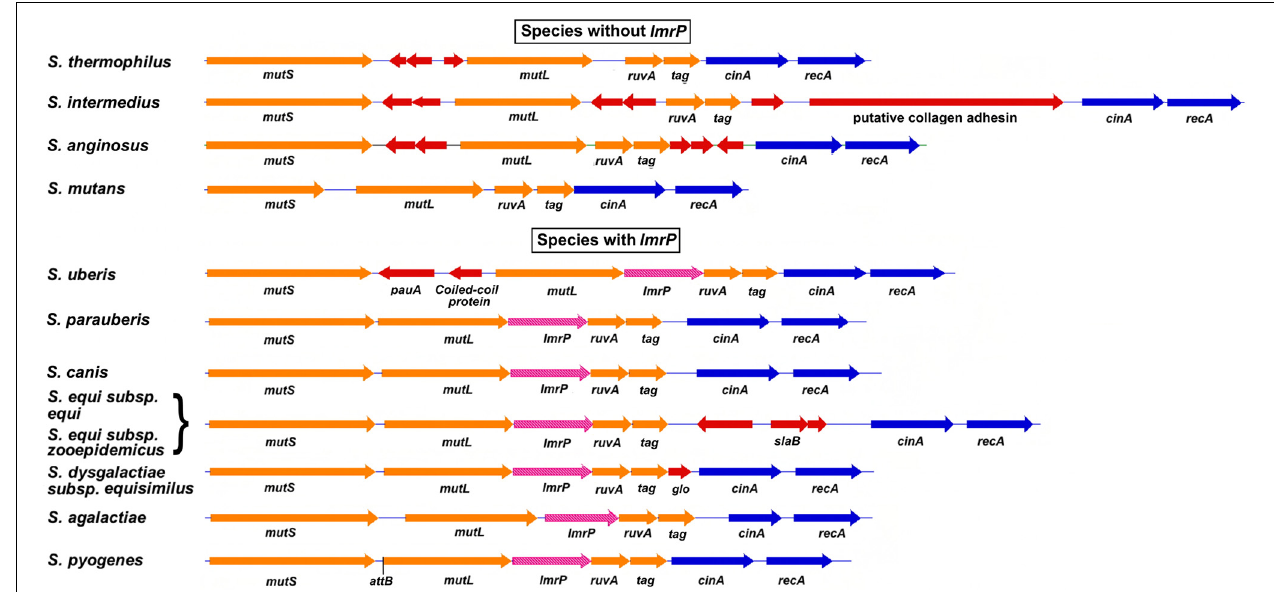
FIGURE 5 | The MMR operon region from selected streptococcal species. The MMR operon in S. pyogenes and related streptococci is composed of a core group of genes involved in MMR, Holliday junction resolution and BER ( mutS , mutL , ruvA , and tag ). Indels are frequently found to supplement this basic genetic unit: MDR gene lmrP forms an additional part of this core in groups A, B, C, and G streptococci. Some indels encode proteins of unknown function, but others appear to encode potential virulence factors such as